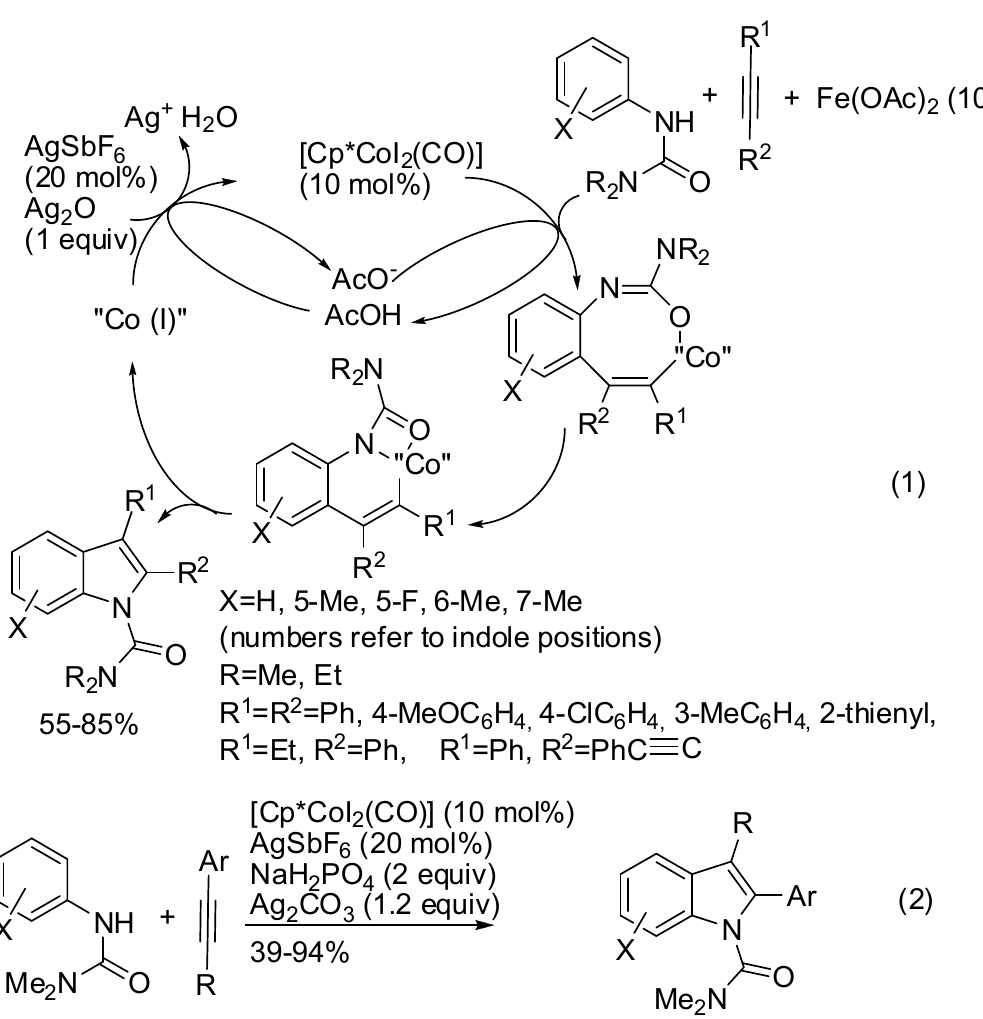
Scheme 3. Cobalt(III)-catalyzed indolization from ureas and alkynes.